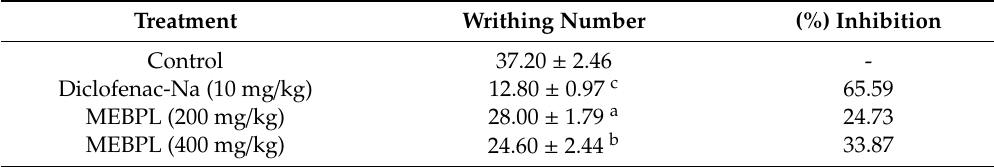
Table 2. Analgesic activity of methanol extract of B. pilosa leaves (MEBPL) in acetic acid induced writhing inhibition test in Swiss albino mice.